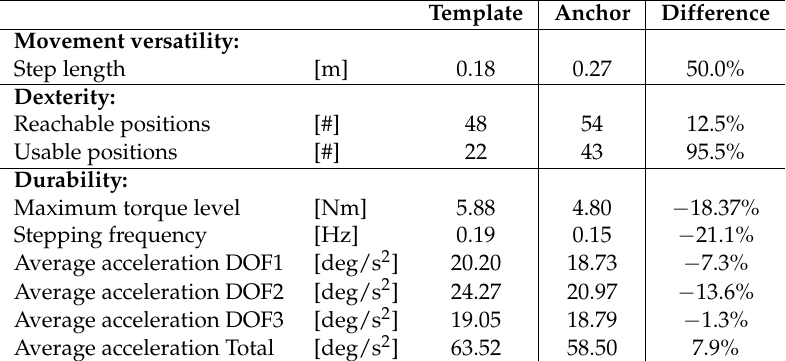
Table 4. Comparison of the template and anchor morphologies’